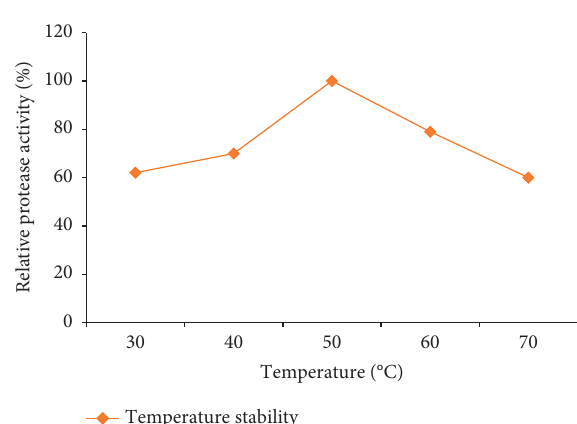
Figure 10: Temperature stability of PA for acetone-precipitated enzyme from the isolate Z1BL1.